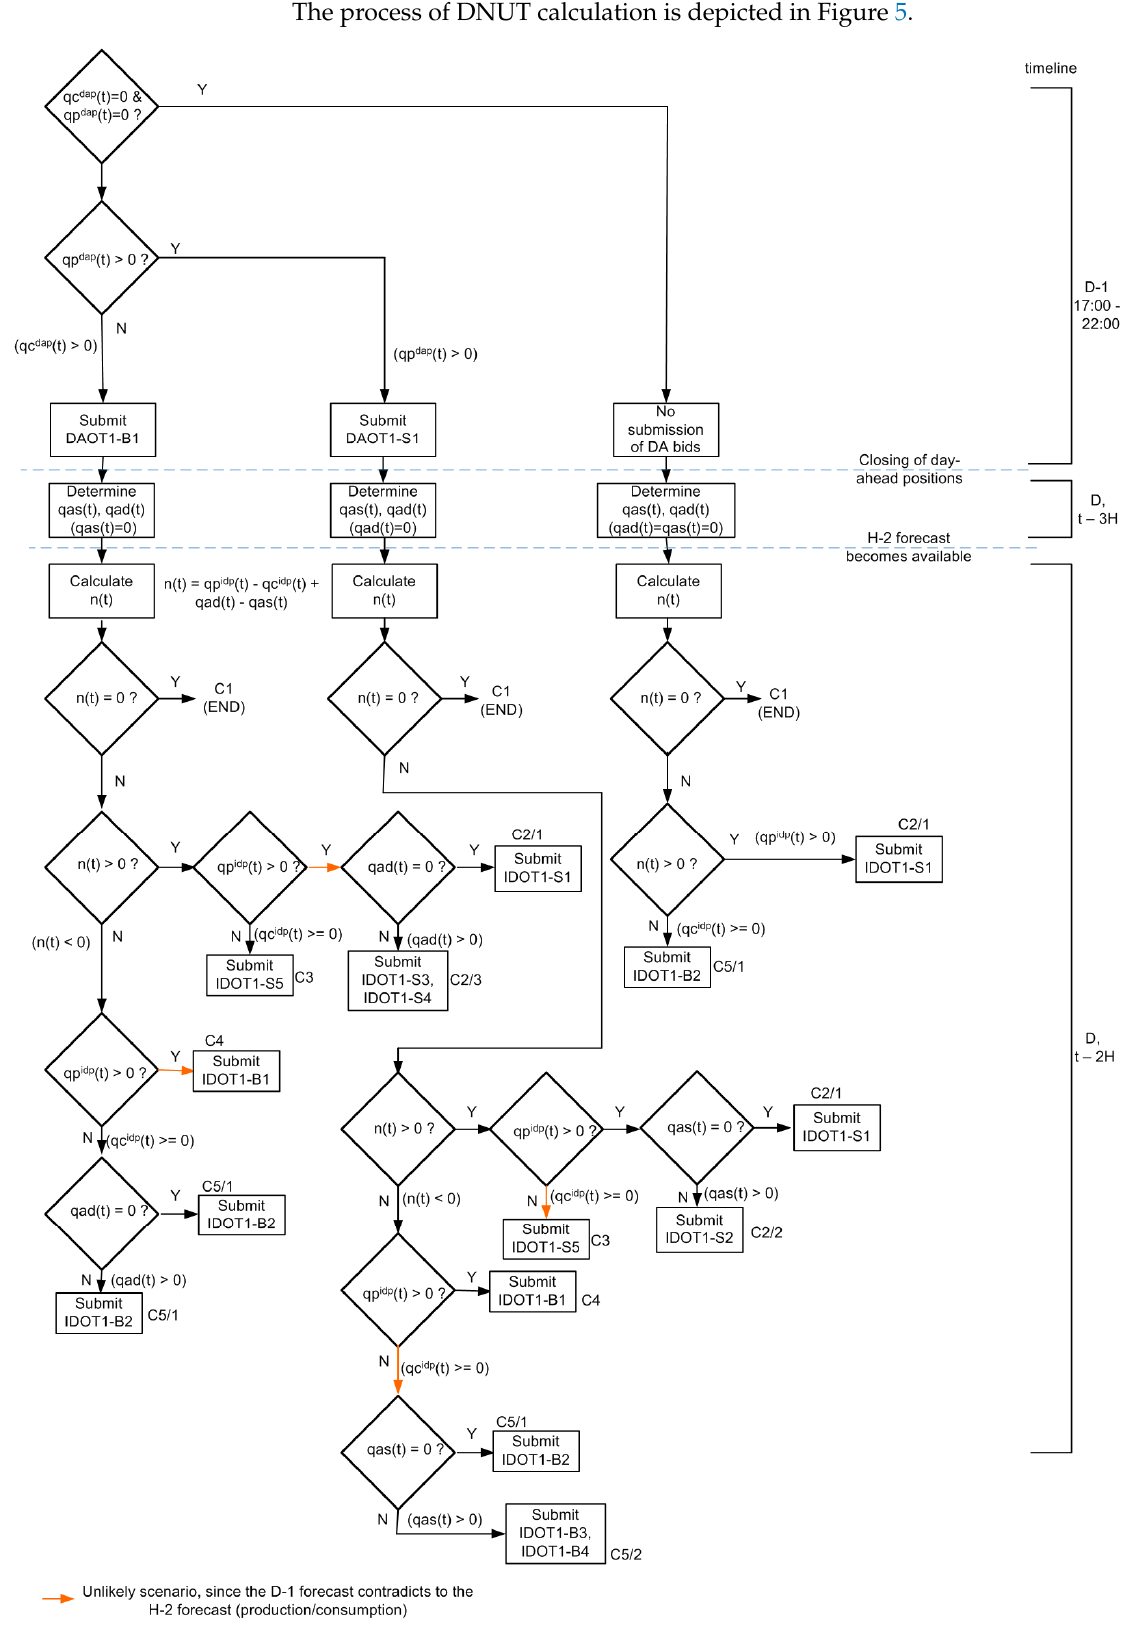
Figure 3. The flowchart of bid generation.